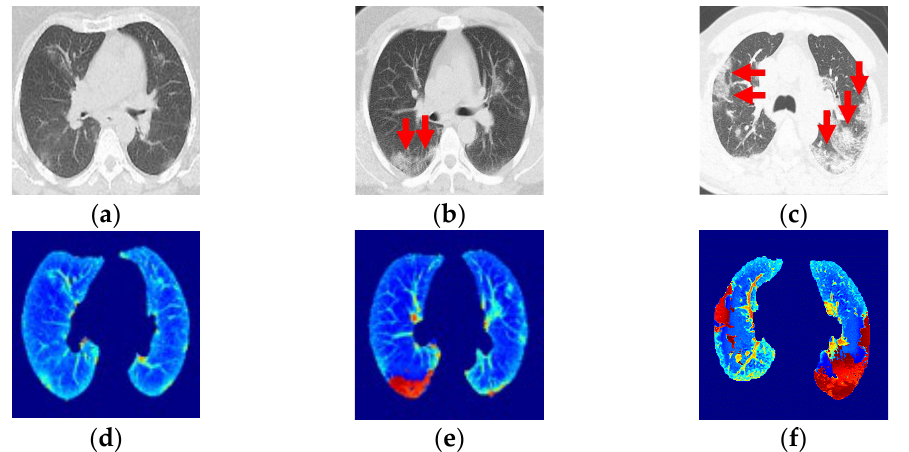
Figure 5. ( a – b ) Ground-glass opacity identification (red arrow marking) for three-class damage pro- gression classification: ( a ) Early phase. ( b ) Progression phase. ( c ) Peak phase. ( d ) Class 1, early phase. ( e ) Class 2, progression phase. ( f ) Class 3, peak phase.